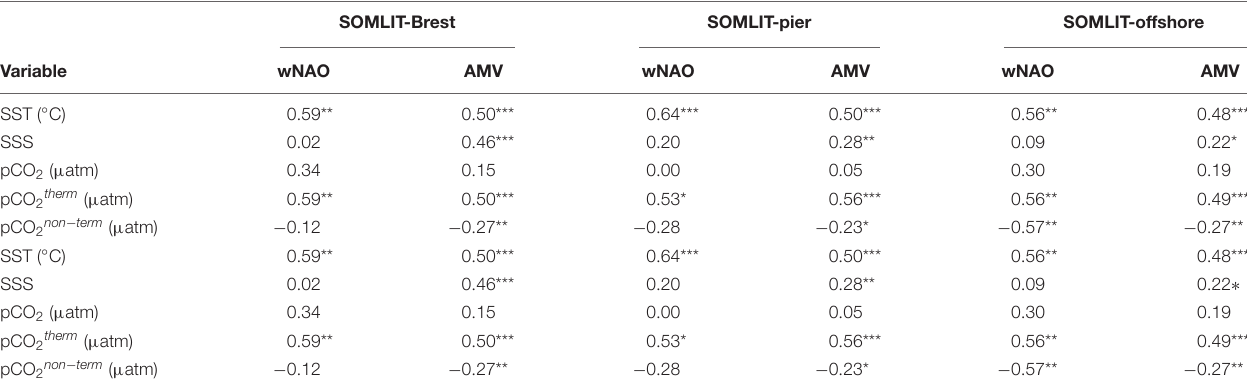
TABLE 3 | Coefficient of determination ( r ) of the Pierson correlations between the monthly anomalies of the winter North Atlantic Oscillation (wNAO) and the Atlantic Multidecadal Variability (AMV), and monthly anomalies of SST ( ◦ C), SSS, pCO 2 , pCO 2 therm , and pCO 2 non − therm (all in µ atm) from 2008 to 2017 at SOMLIT-Brest, SOMLIT-pier, and SOMLIT-offshore. SOMLIT-Brest